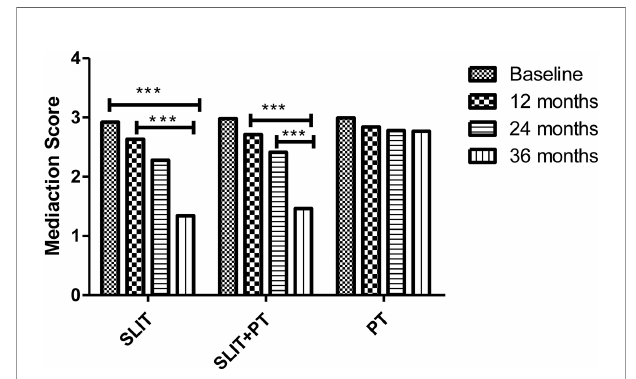
FIGURE 3 | Medication scores of three treatment groups at different stages. *** denotes level of statistical signi fi cance.